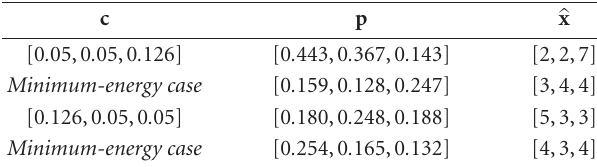
Table 2: Results of maximum-lifetime path configuration.